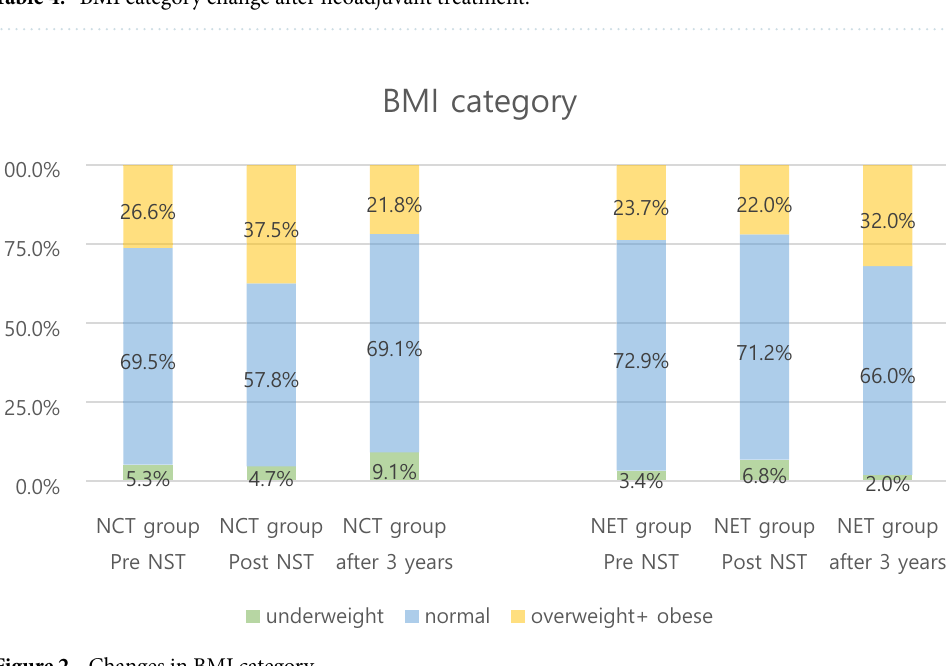
Table 4. BMI category change after neoadjuvant